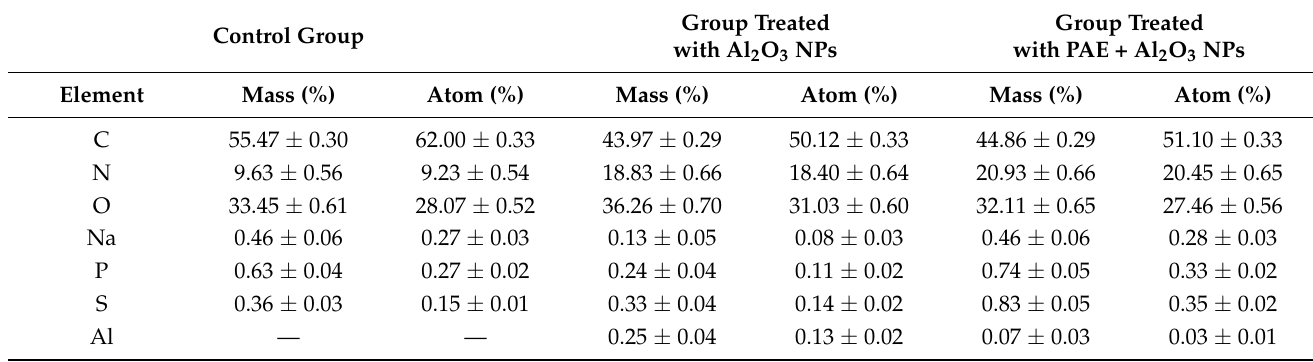
Table 1. EDX analysis of testicular tissues from L. migratoria in response to Al 2 O 3 NPs and PAE